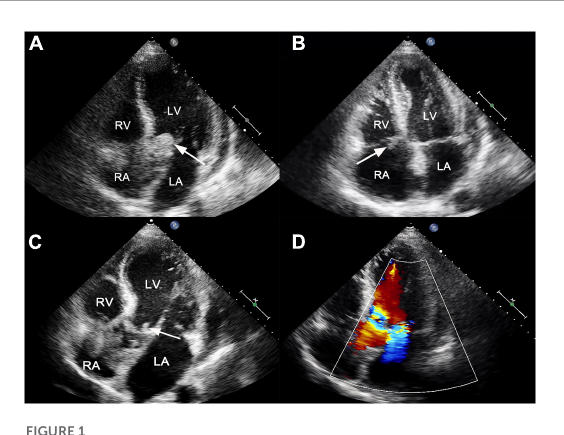
FIGURE1 (A) Transthoracic echocardiogram showed a large, mobile vegetation on the ventricular side of the prosthetic valve (white arrow). (B) A vegetation was also visible on the tricuspid valve (white arrow). (C) Transthoracic echocardiogram reexamination showed residual vegetations on prosthetic aortic valves with reduced size (white arrow). (D) The new mitral valve moderate regurgitation. LA, left atrium; LV, left ventricle; RA, right atrium; RV, right